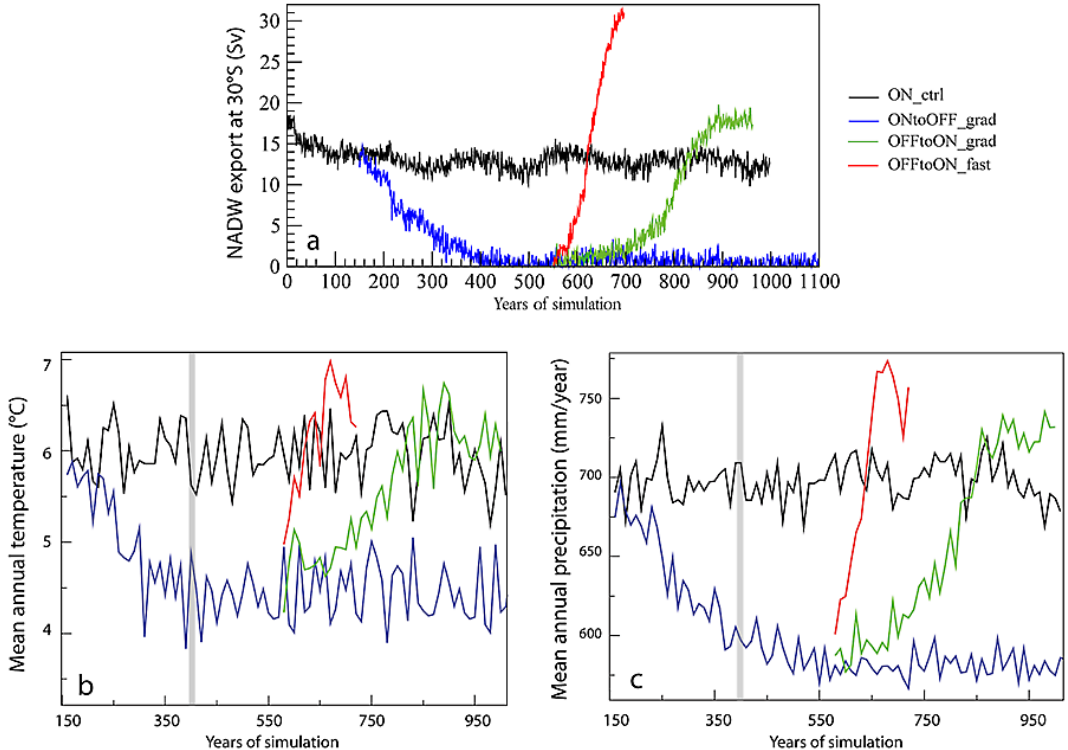
Fig. 1. (a) Temporal evolution of the NADW export at 30 ◦ S, in Sv. (b) Evolution of the mean annual temperature ( ◦ C) and (c) the mean annual precipitation over Western Europe (lat=32/60 ◦ , lon= − 15/20 ◦ ) for ON ctrl, ONtoOFF grad, OFFtoON grad and OFFtoON fast.The curves correspond to values averaged only over the land points and for successive periods of 10yr of the simulations. The vertical grey bars indicate when the AMOC is fully collapsed in ONtoOFF